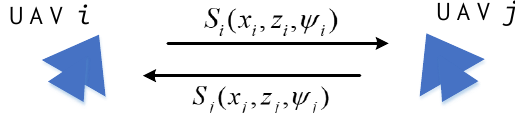
Figure 2. Information exchange of distributed UAV control system.